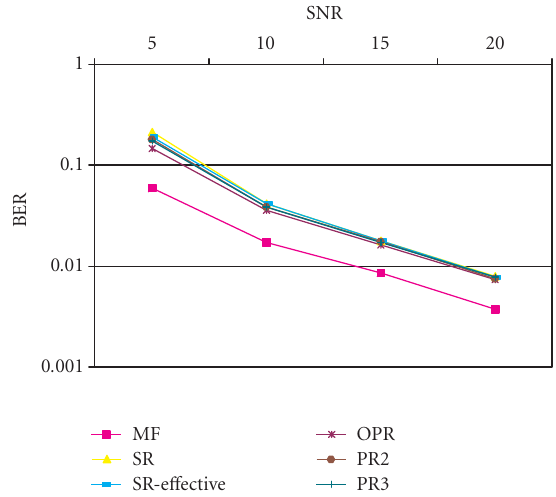
Figure 6: Comparison of the PR2, PR3, and OPR algorithms with SR applied to the joint detection and estimation